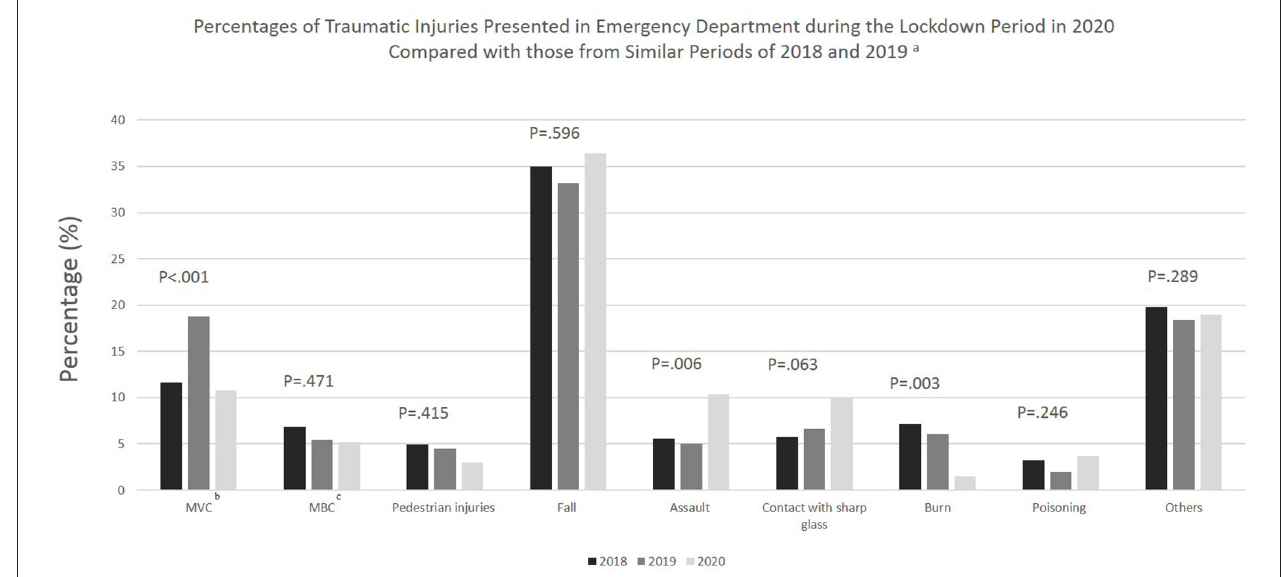
FIGURE 1 | Percentages of traumatic injuries presented in emergency department during the lockdown period in 2020 compared with those from similar periods of 2018 and 2019. a P -value (P) are produced from Chi-squared test. P -value is considered significant when < 0.05. b MVC, Motor-vehicle crashes. c MBC, Motorcycle and bicycle